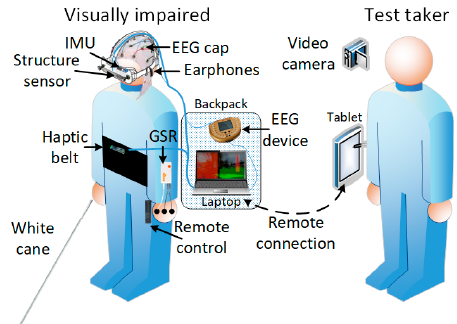
Figure 1. Real-world setup. IMU- Inertial Motion Unit, EEG–Electroencephalography, GSR–Galvanic Skin Response.